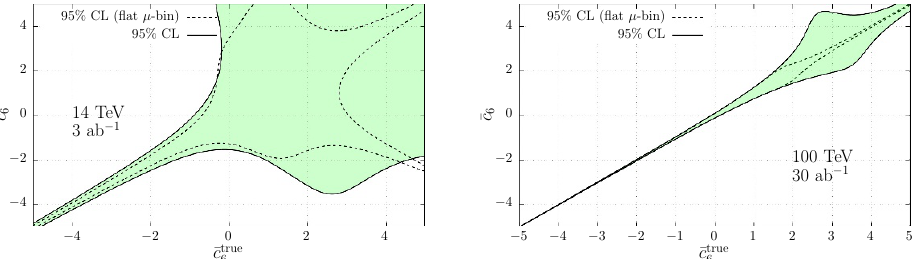
Figure 11 . Sensitivity (2 (cid:27) bounds) on (cid:22) c 6 as function of c true